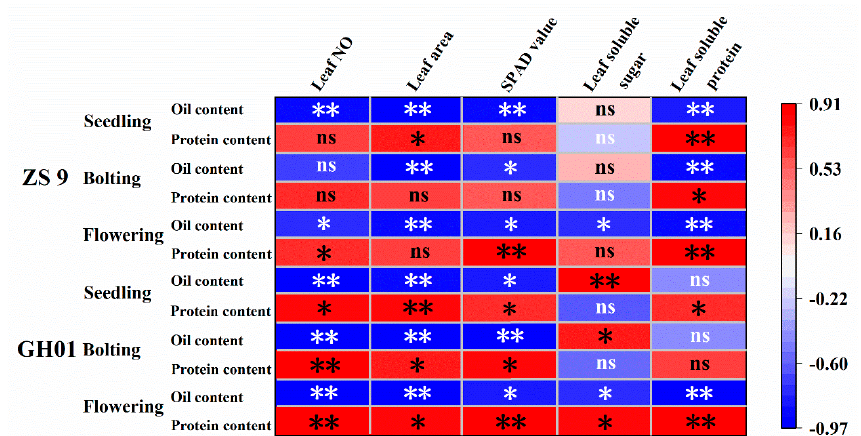
Figure 7. Correlation analysis of leaf traits with seed oil and protein content at different growth stages. n = 8, R 0.05 = 0.707, R 0.01 = 0.834; * and ** significance at the 0.05 and 0.01 levels, respectively.